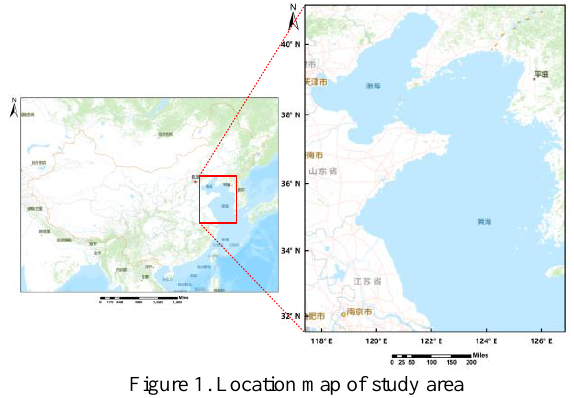
Figure 1. Location map of study area